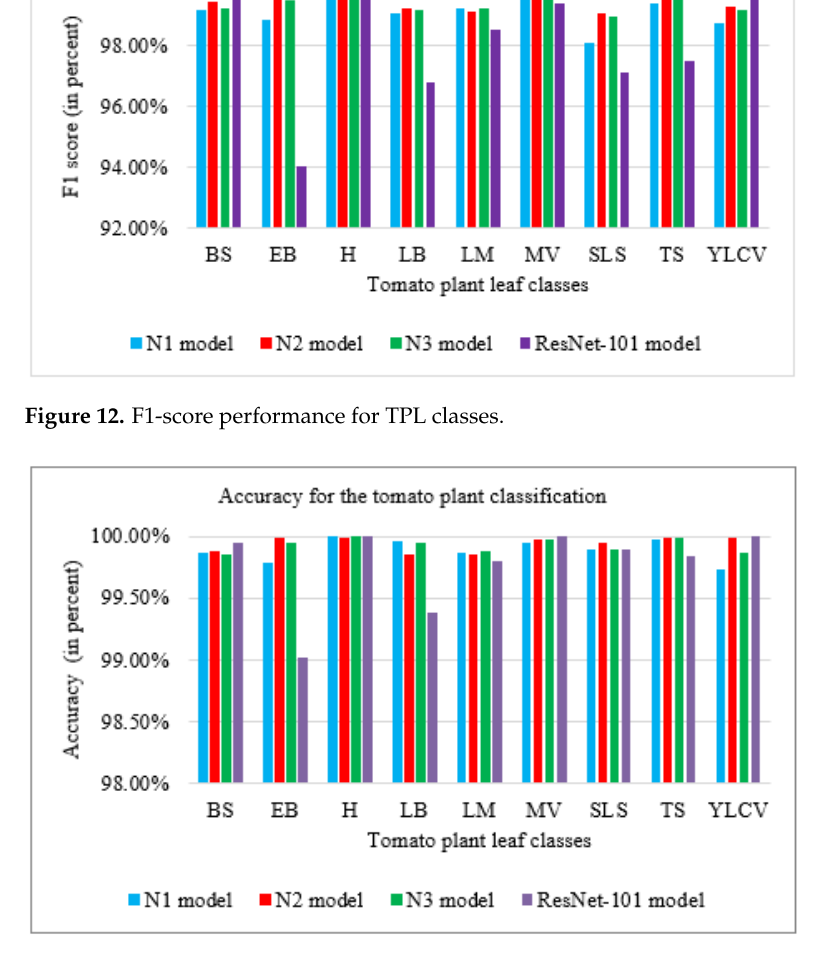
Figure 13. Accuracy performance for TPL